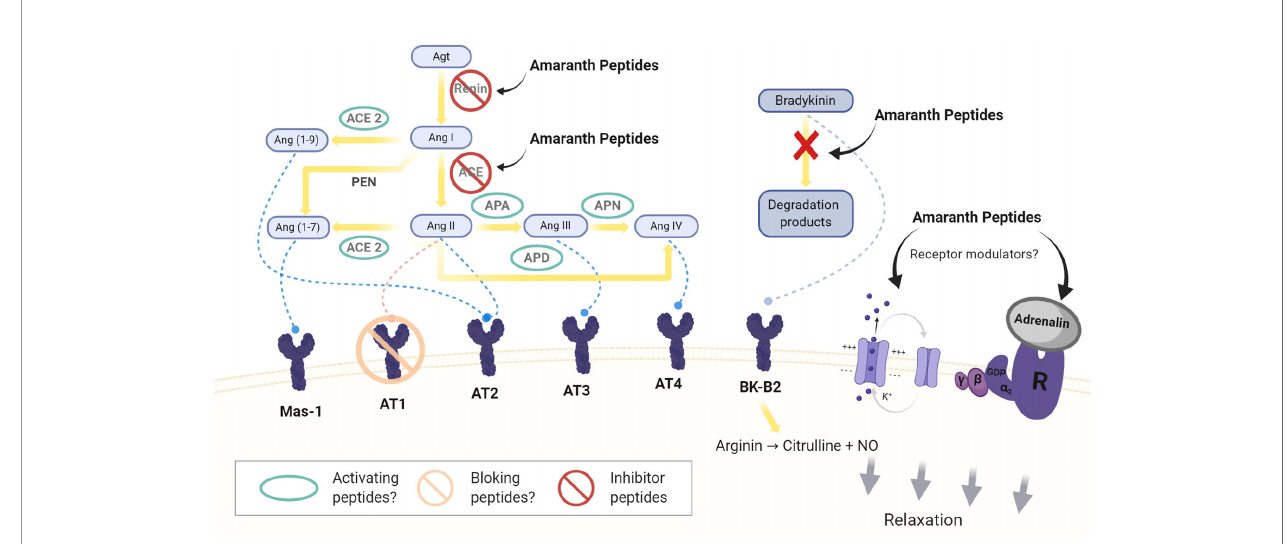
FIGURE 1 | Sites of action of amaranth peptides in the circulating and local RAAS system. Agt: angiotensinogen; Ang I, II, III, IV, (1-9), (1-7): angiotensin I, II, III, IV, (1-9) and (1-7); ACE: angiotensin converting enzyme; APA, APN, and APD: aminopeptidases A, N, and P; PEN: neutral peptidases. Mas-1: Mas-1 receptor, AT1: angiotensin II type1 receptor, AT2: angiotensin II type 2 receptor, AT3: angiotensin III receptor AT4: angiotensin IV receptor. BK-B2: bradykinin B2